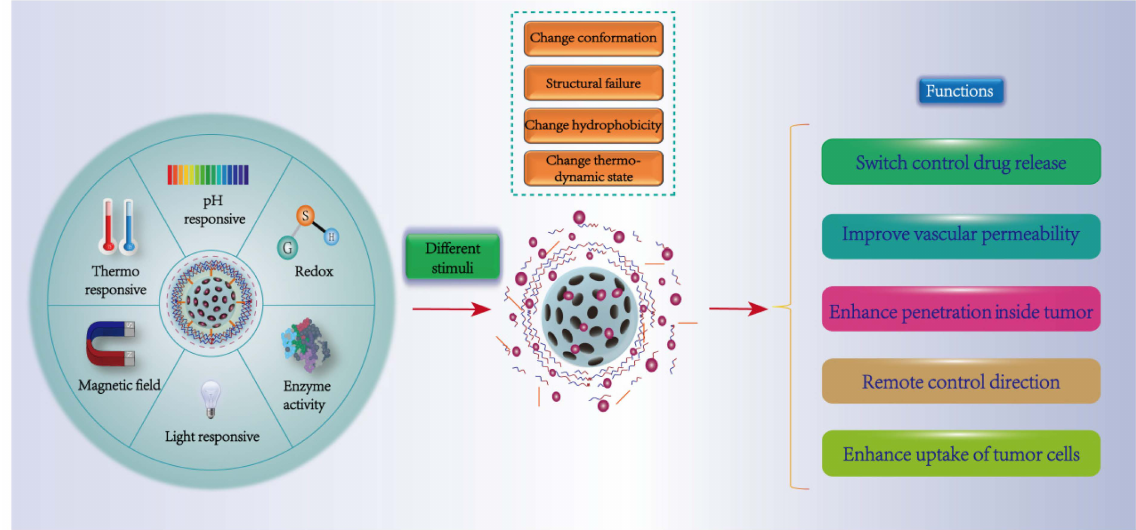
Figure 4. Schematic diagram of targeted drug delivery by NPs under different